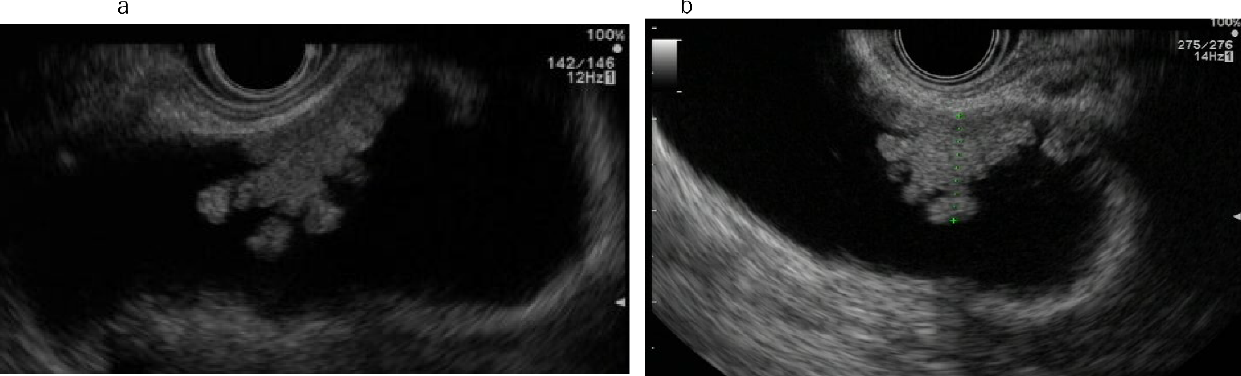
Figure 3. Intracystic papillary neoplasm (ICPN; adenocarcinoma: m). ( a , b ) Endoscopic ultrasonography (EUS): Broad-based elevated lesion.